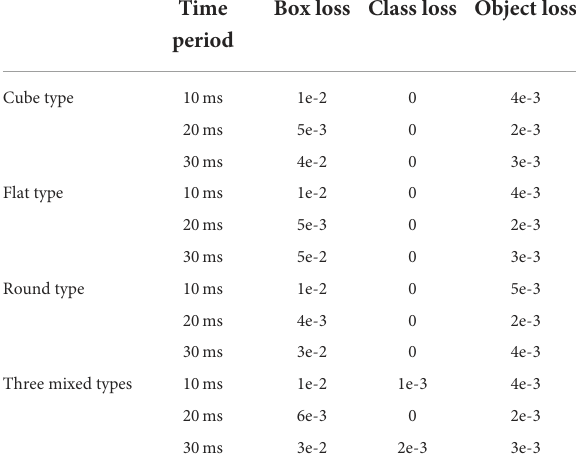
TABLE 3 The encoding time-intervals’ comparisons for different delivery